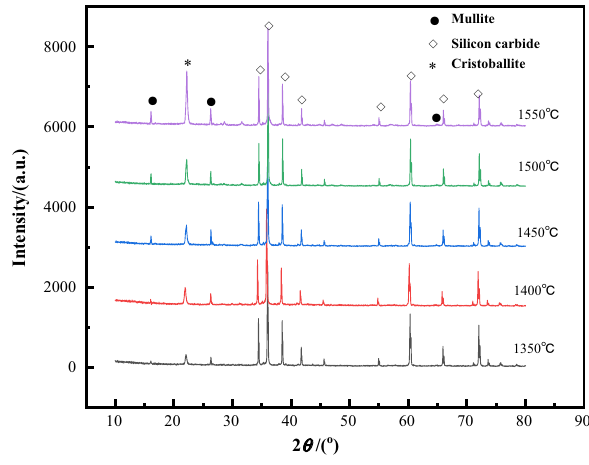
Fig. 2 XRD patterns of the specimens sintered at 1350–1550 °C for 2 h in the air